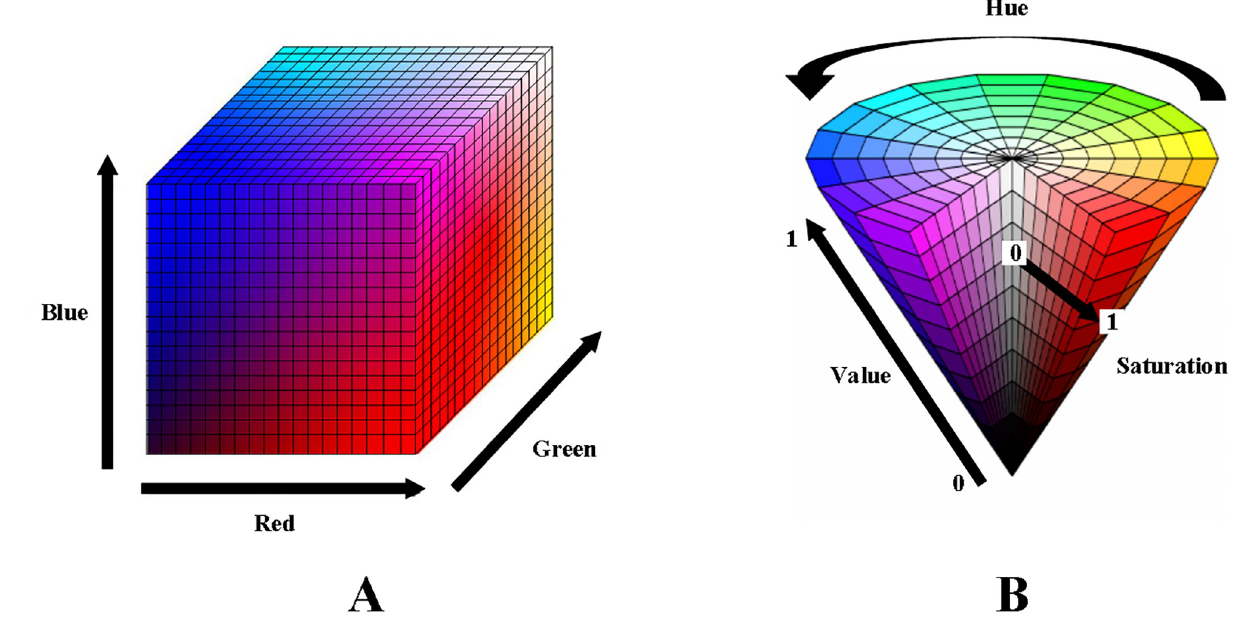
Fig 1. Color distribution RGB space and HSV space (A is RGB space; B is HSV space). of the two types of color space are red-green-blue (RGB) space and hue-saturation-value